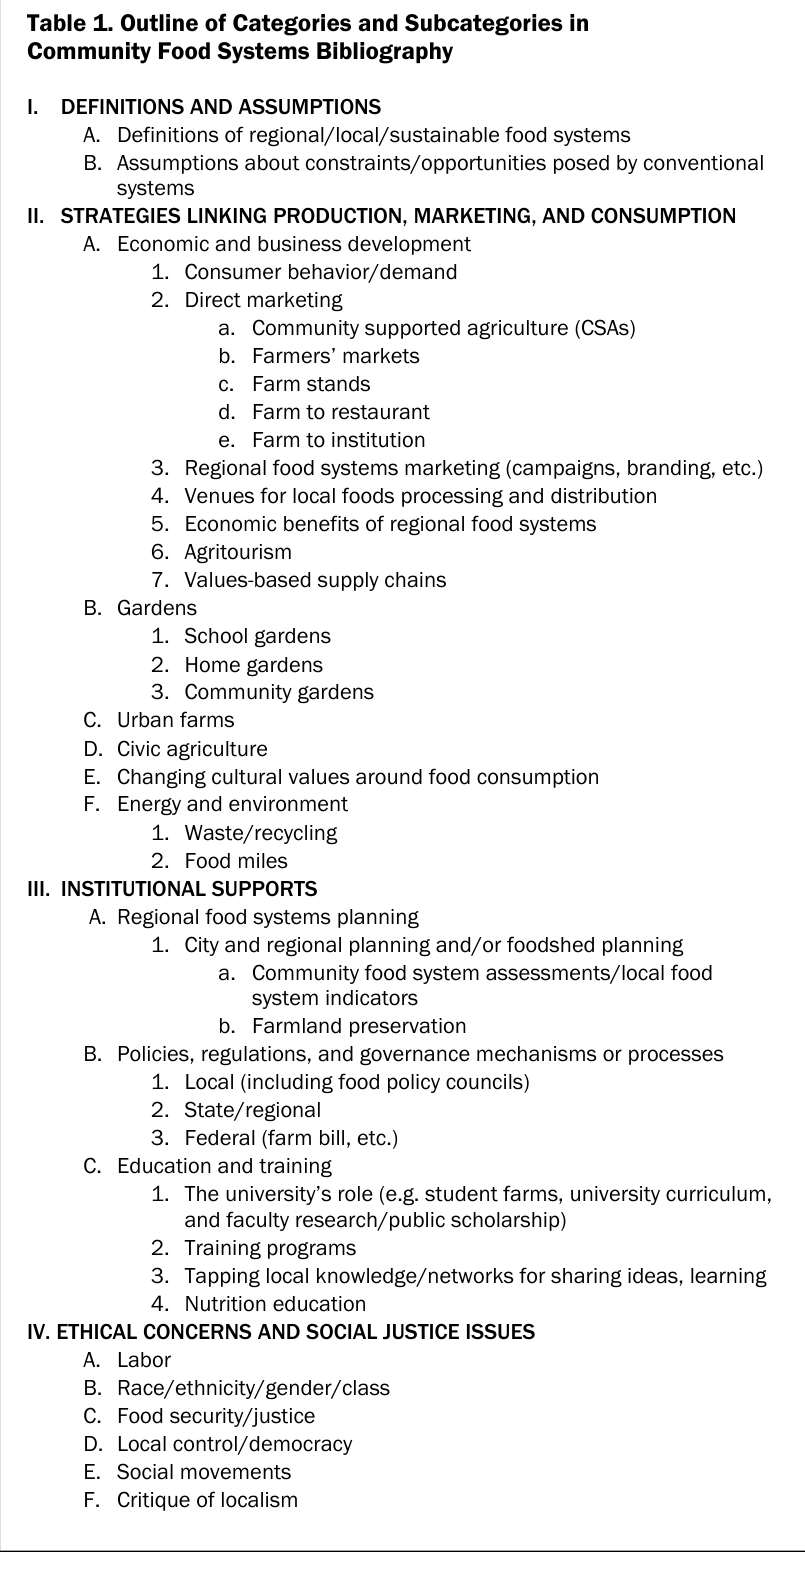
Table 1. Outline of Categories and Subcategories in Community Food Systems